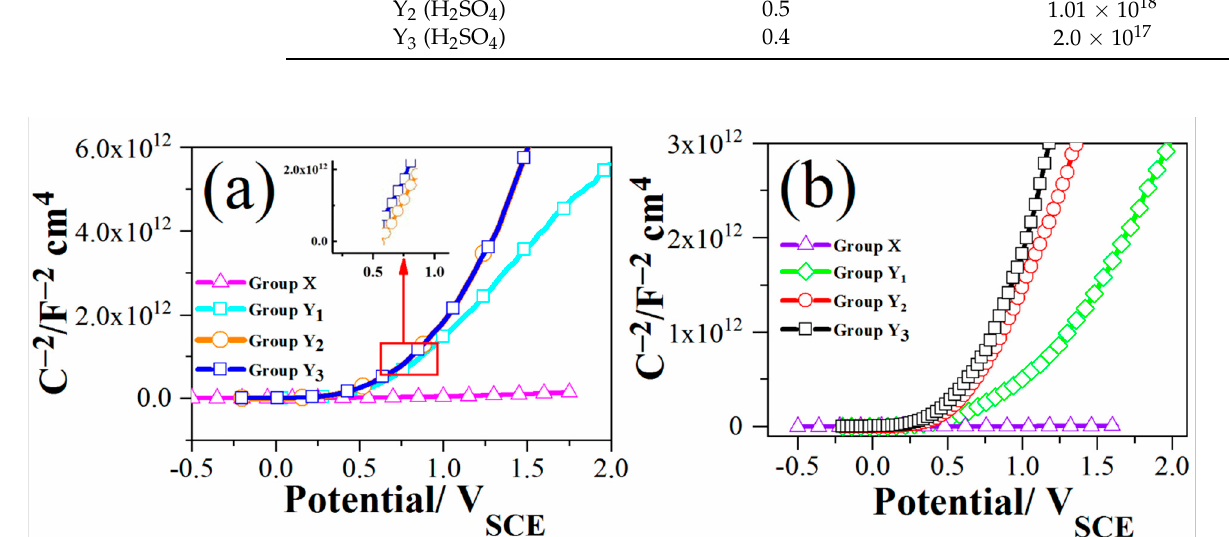
Figure 7. M-S plots of groups X, Y 1 , Y 2 and Y 3 at 100 ± 5 °C: ( a ) 4 M HCl; ( b ) 4 M H 2 SO 4 .